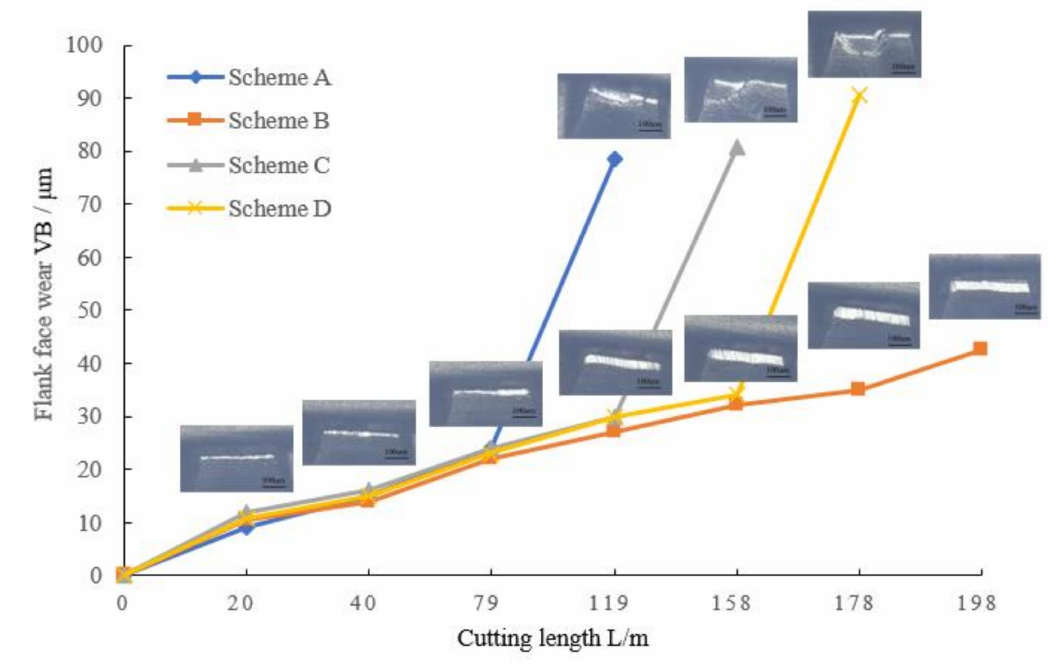
Figure 7. Wear curve about flank face of circumferential